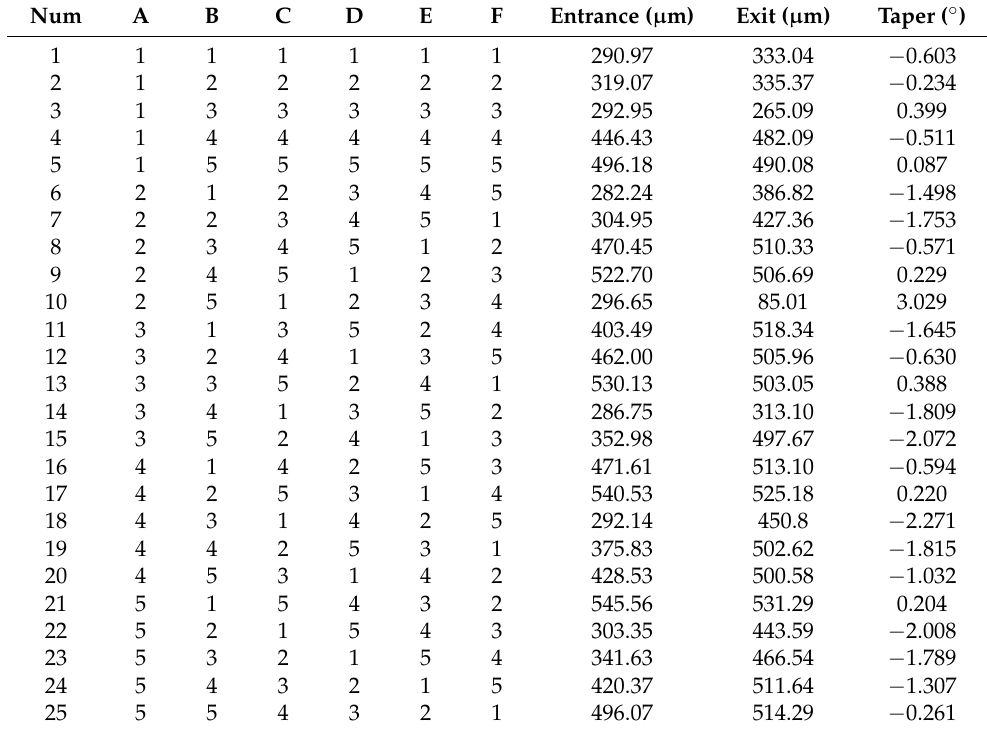
Table 3. Orthogonal design and measurement results of DD6 single crystal superalloy.